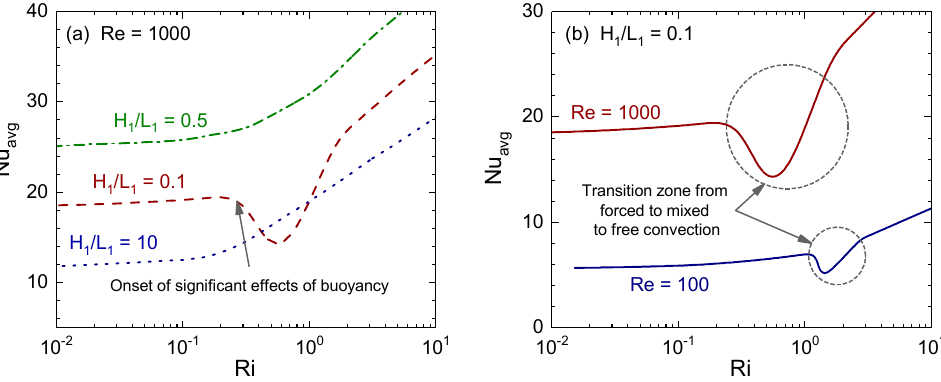
Figure 15. Effect Richardson number on Nu avg for various fin aspect ratios and Reynolds numbers. The onset of significant effects of buoyancy in part ( a ) and the transition zones are highlighted with dashed circles in part ( b ).